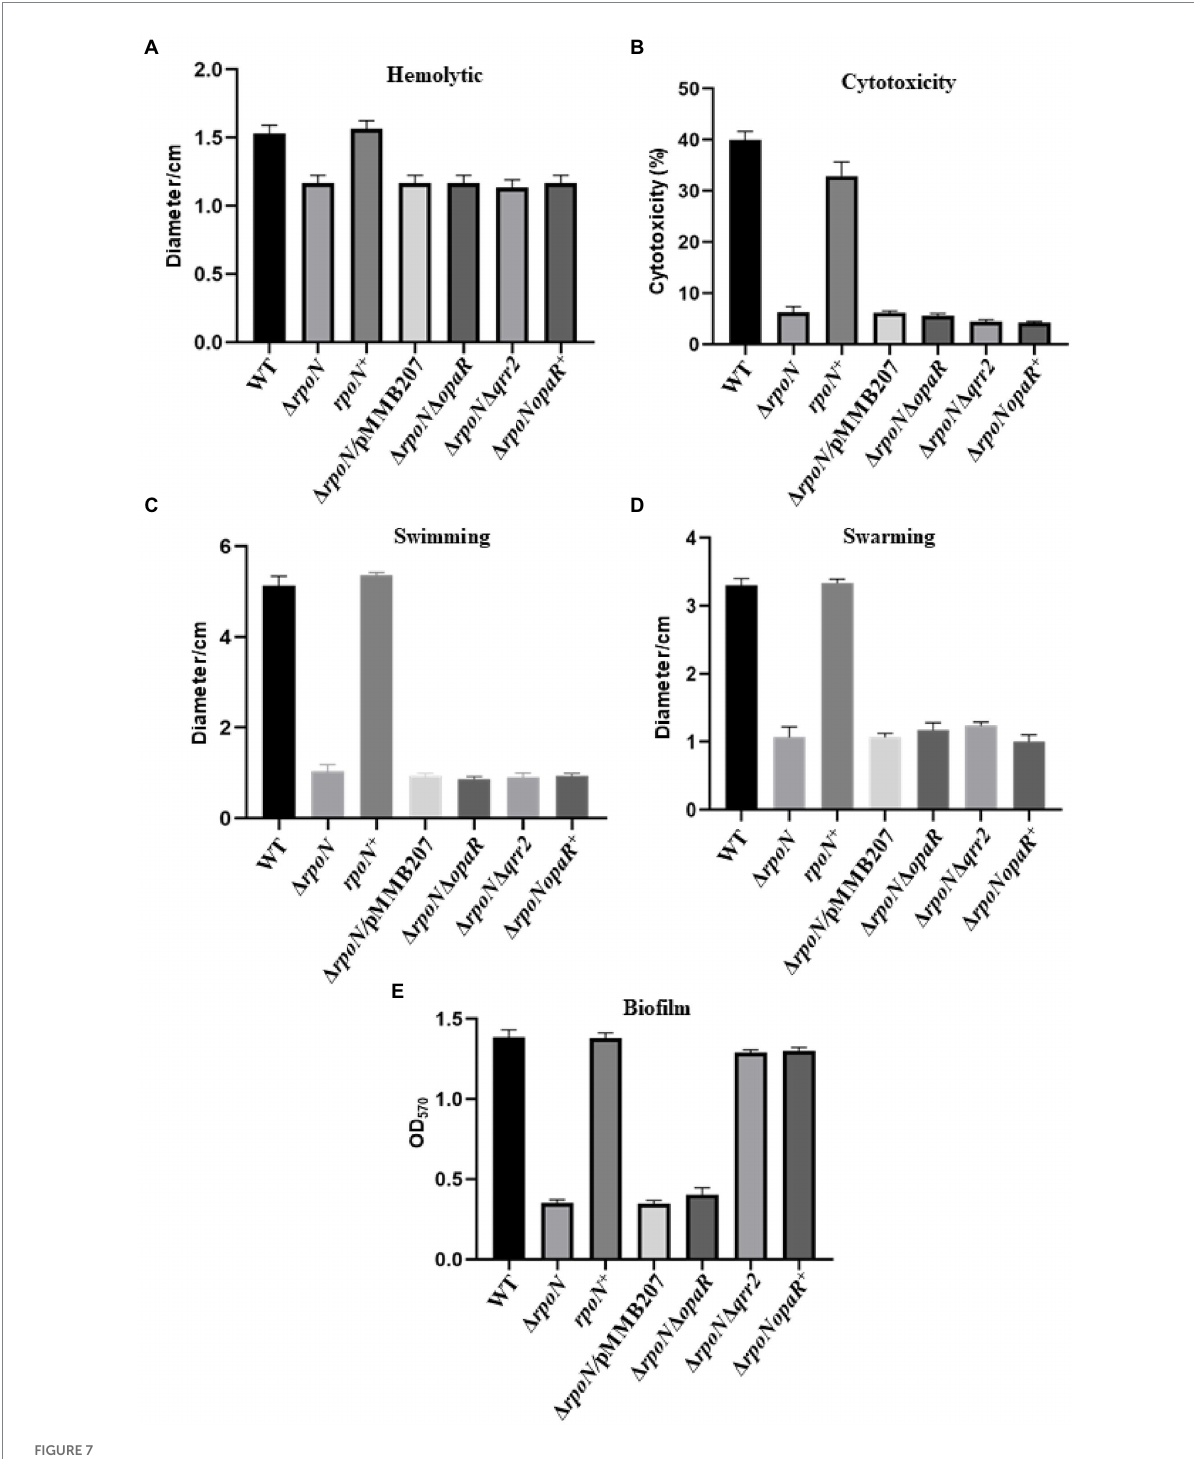
FIGURE 7 The RpoN regulates the phenotypes in an OpaR-dependent or OpaR-independent way. (A) Hemolytic activity assay of WT, ∆ rpoN , rpoN + ,